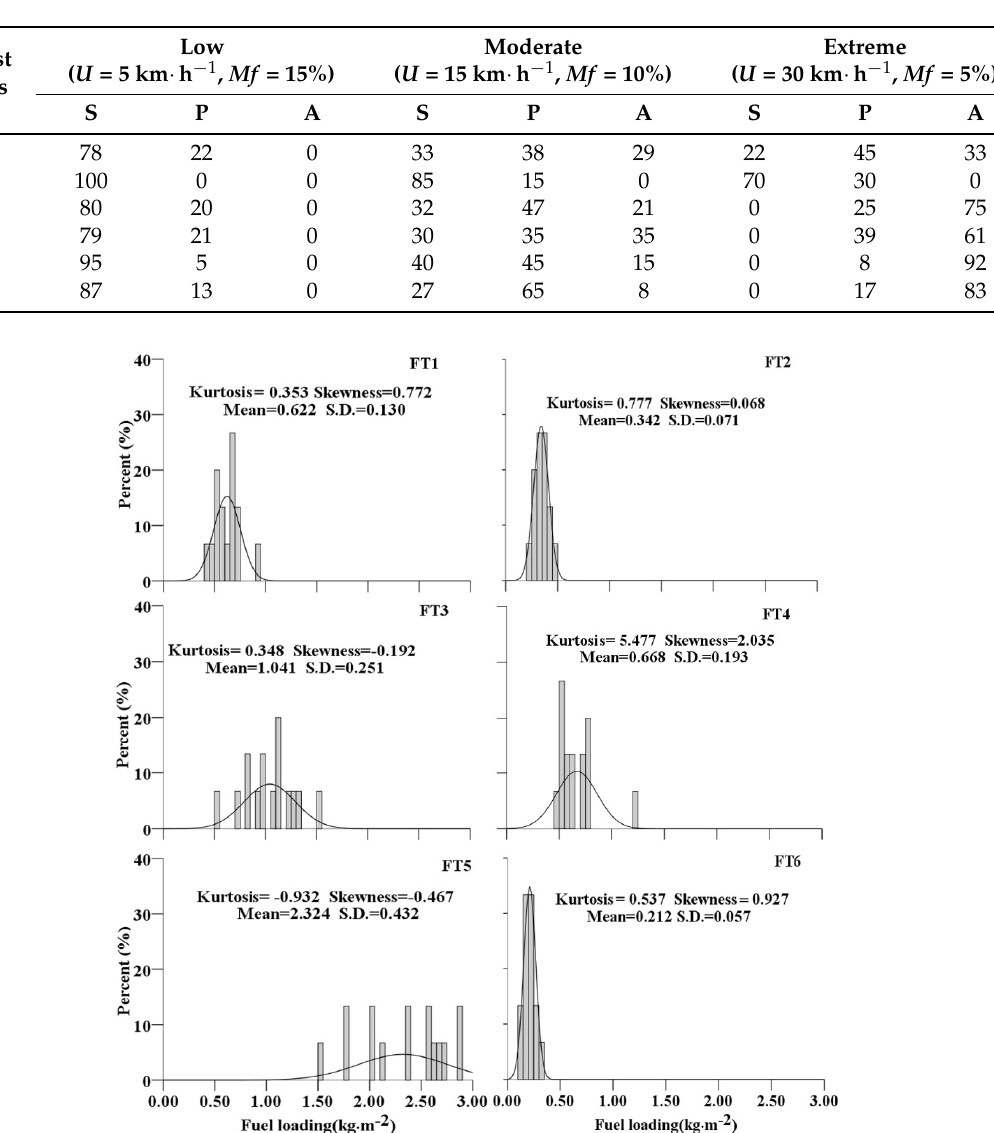
Figure 2. Observed (bar) and fitted (curve) distributions of surface fuel loading by six forest types.